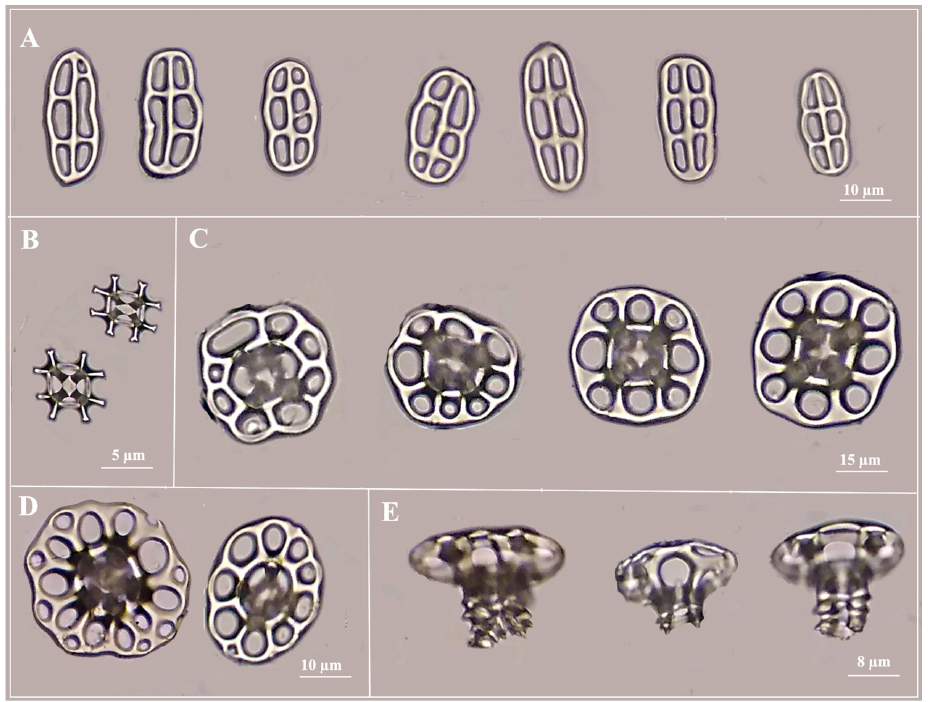
Figure 2. Ossicles of the species Holothuria impatiens : ( A ) different button structures; ( B ) grid struc- ture; ( C ) table with eight holes; ( D ) table with nine or more holes; and ( E ) table side view. The button length deviations ranged from 69.5 to 97.2 µm for Rg1, from 63.8 to 77.4 µm for Rg2, and from 65.7 to 80.4 µm for Rg3. The widths of the buttons recorded devia-